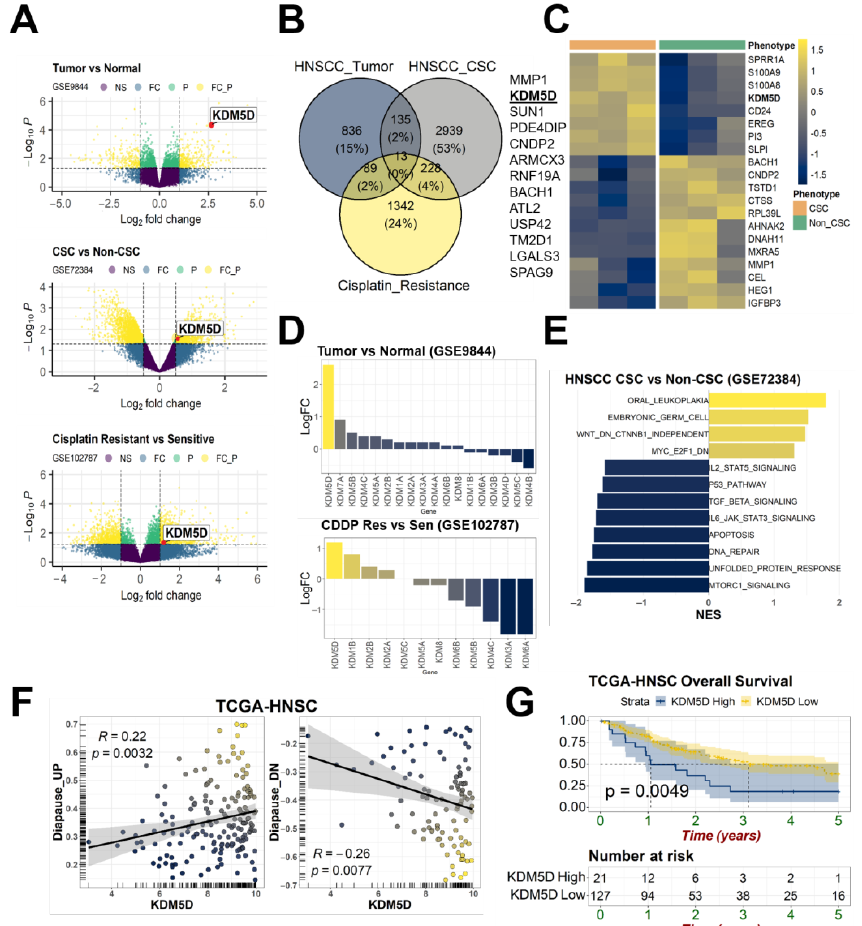
Figure 1. Differentially expression of KDM5D linked HNSCC Tumors, CSCs, and Cisplatin Resistance. ( A ) Individual volcano plots depicted overexpression of KDM5D as DEGs in respective phenotypes and datasets: Tumor versus Normal (GSE9844), CSCs versus Non-CSCs (GSE72384), and Cisplatin Resistant versus Sensitive (GSE102787). The position of KDM5D was marked in red dot with respective arrow. ( B ) Venn diagram depicts shared common DEGs between HNSCC tumors, CSCs subset, and cisplatin resistant cells, in which KDM5D belongs to one of the shared genes. ( C ) The heatmap of GSE72384 microarray dataset described cluster analysis of previously described top DEGs, which appropriately categorized each sample into CSCs and non-CSCs subsets. ( D ) Compared with all recognizable lysine demethylases belonging to the JARID or KDM family in humans, KDM5D was relatively highly expressed in HNSCC tumors and cisplatin-resistant cells. ( E ) The GSEA findings revealed that several crucial signaling pathways were activated or deactivated and linked to cancer stemness in HNSCC. ( F ) The scatter plot revealed that KDM5D expression was positively correlated with genes upregulated in the diapause-like state (r = 0.22, p = 0.0032) and negatively correlated with genes downregulated in the diapause-like state (r = − 0.26, p = 0.0077). Diapause gene set scores of each sample were calculated by GSVA method. ( G ) A higher KDM5D expression level was associated with poorer overall survival in patients in the TCGA-HNSC dataset ( p = 0.0049). NS: Not Significant, FC: Significant in Log2 Fold-Change, p : Significant in p -value, FC_P: Significant in Log2 Fold-Change and p -value, NES: Normalized Enrichment